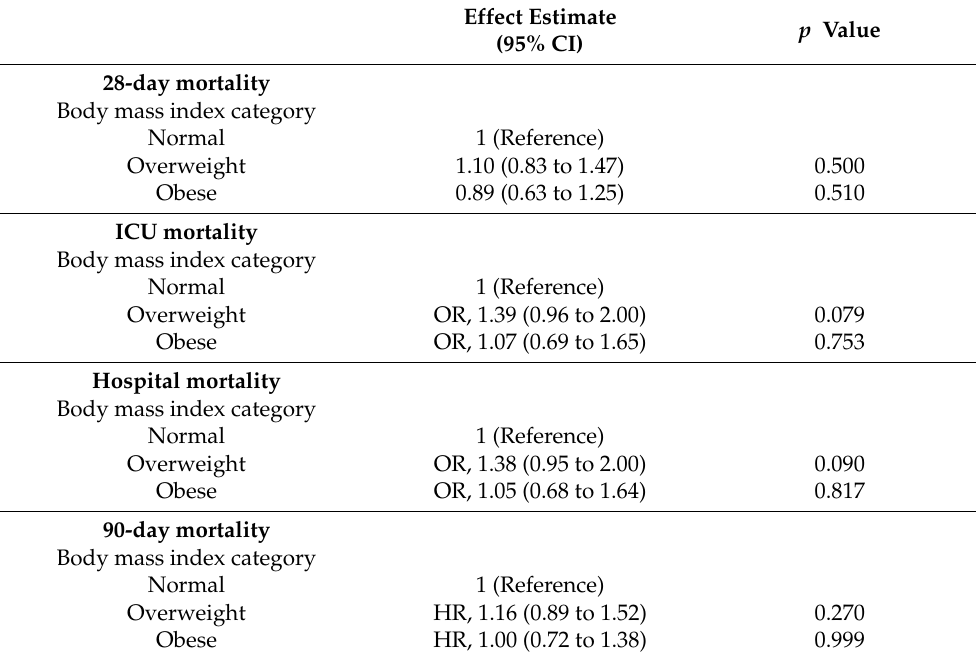
Table 3. Adjusted effect of body mass index categories in 28-day, ICU, hospital, and 90-day mortality